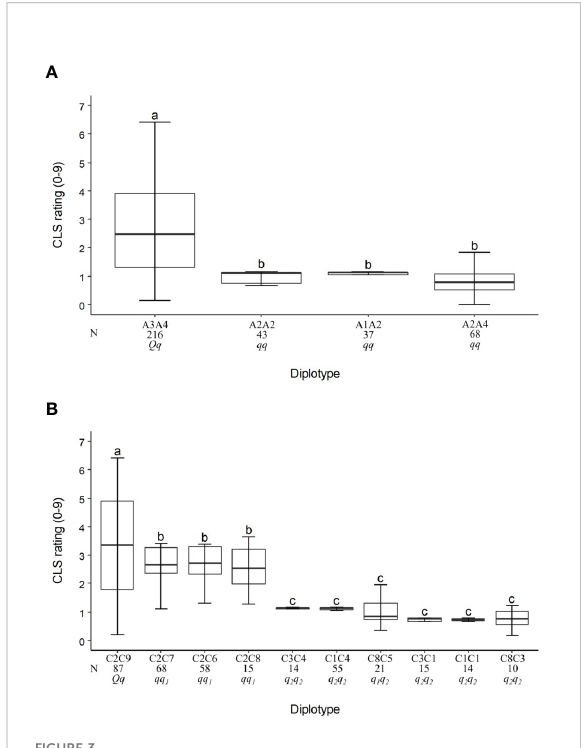
FIGURE 3 Diplotype effect of the most common haplotypes associated with cercospora leaf spot QTLs q CLS.TX2WOB-LG3.2 (A) and q CLS.TX2WOB-LG4.2 (B) in 11 diploid rose populations (TX2WOB). Means not connected by the same letter are signi fi cantly different ( P<0.05 ) within each linkage group. N = Diplotype sample